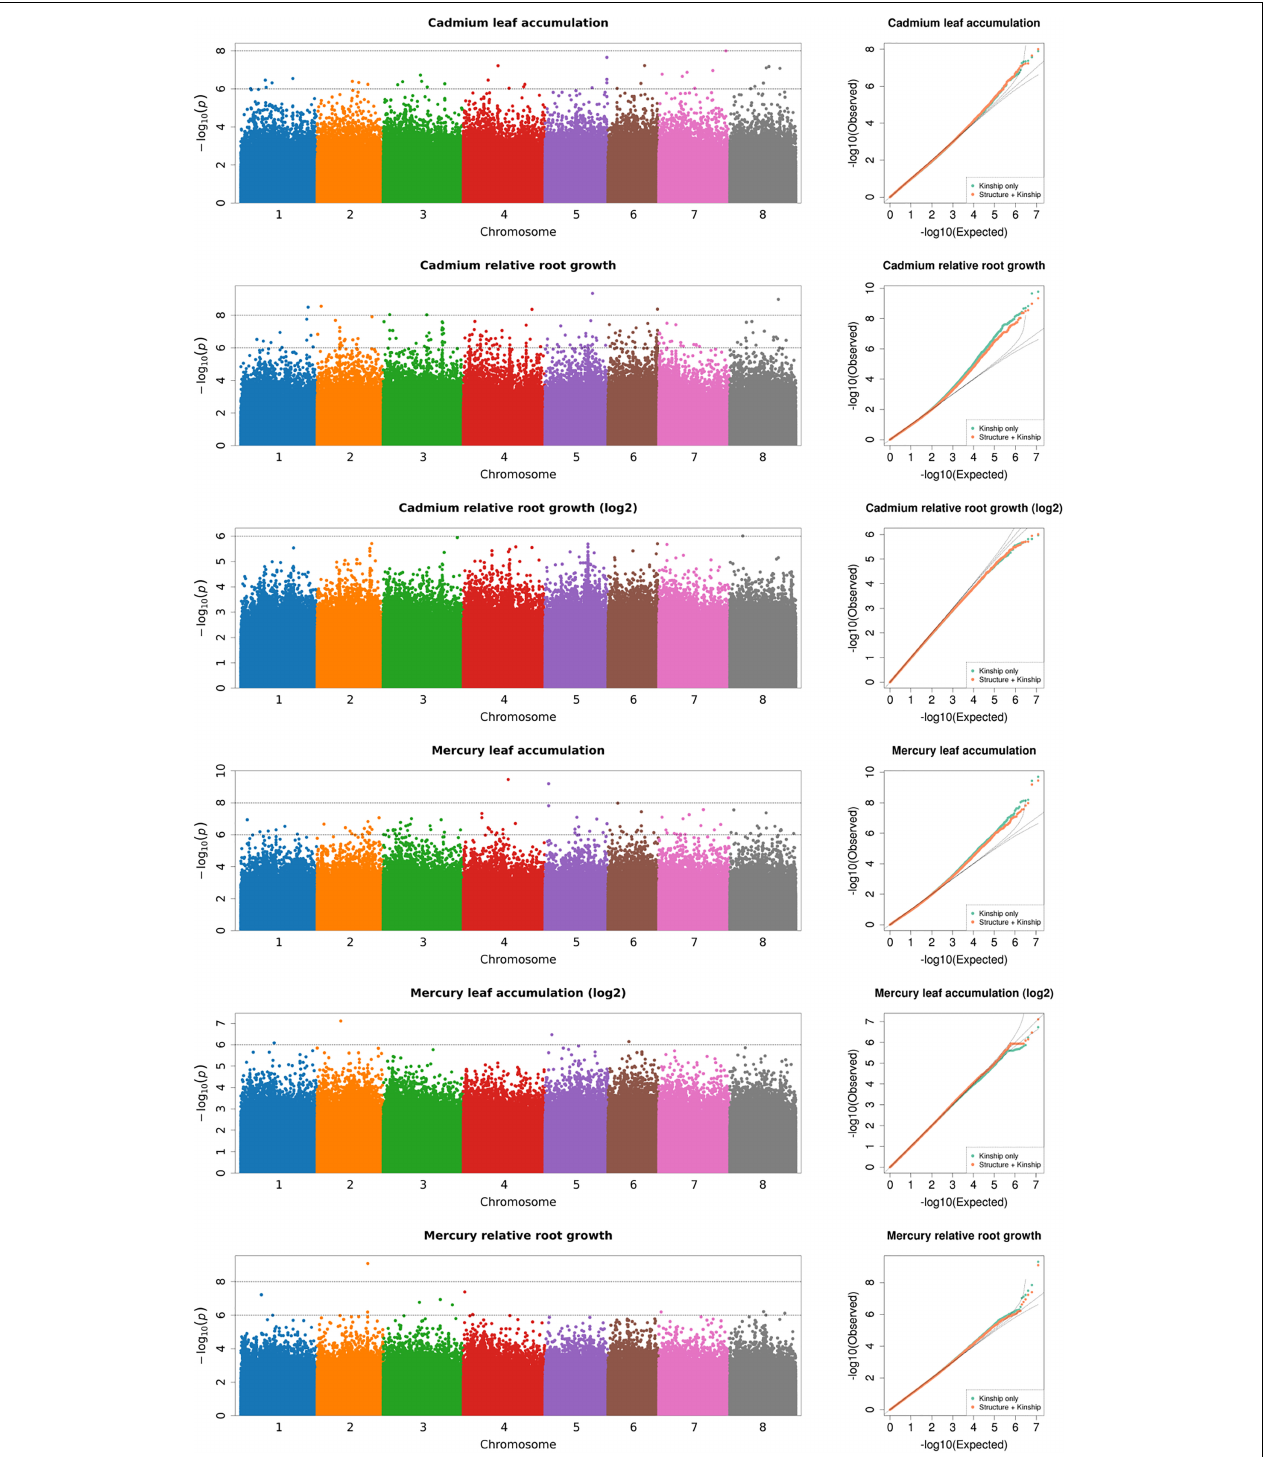
FIGURE 2 | Genome-wide association analysis of heavy metal accumulation and tolerance traits (Manhattan plots shown for each trait; output from GAPIT). Each point represents a SNP at each position in the genome. The number on the x -axis is the chromosome (each color corresponds to one of the eight Mt4.0 chromosomes). The y -axis is the negative log 10 of the p -values. The higher y -axis values indicate smaller p -values. Next to each Manhattan plot are quantile-quantile (Q-Q) plots which show the model fit with population structure covariance included (orange points), and without population structure covariance (green points). The x -axis of the Q-Q plots is the expected distribution, the y -axis is the empirical distribution.